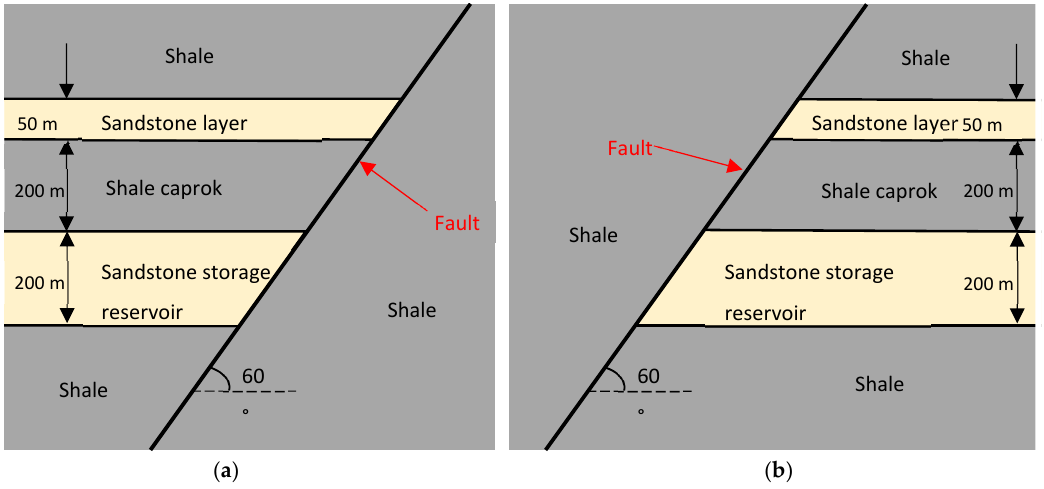
Figure 2. Diagram of the simulation domain. ( a ) Sandstone formations are in the hanging wall; ( b ) Sandstone formations in the footwall. Note that these diagrams are schematic and do not show the fault structure (process zone).